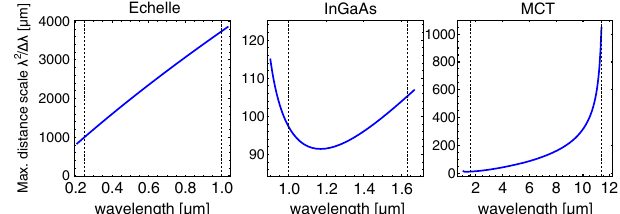
FIG. 14. Shows the maximum bunch spacings L ¼ cT ¼ = Δ λ λ 2 0 from trains of electron bunches [32] detectible by the 0 spectrometer. At any given wavelength, the maximum resolvable distance scale L between two bunches of a periodic bunch signal is defined by the instrument relative resolving power λ = Δ λ , corresponding to the absolute instrument resolution data of Fig. 13. Each detector ’ s spectrum is delimited by grey lines to indicate the later composite spectral range without overlapping wavelengths.